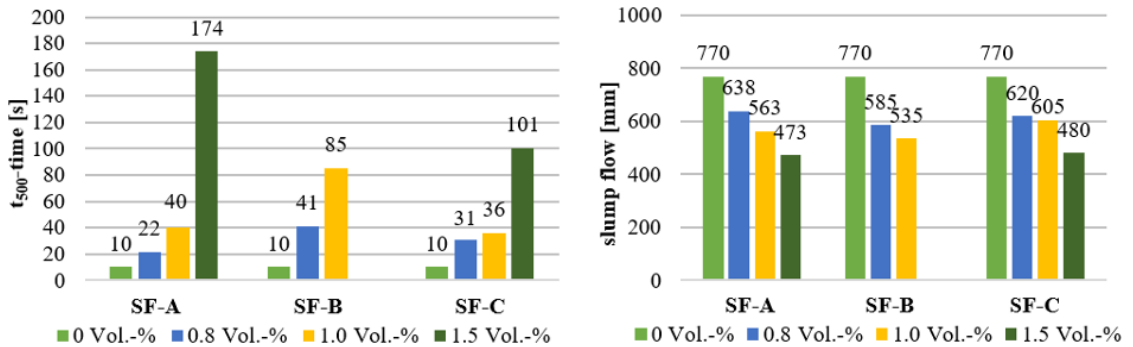
Figure 2. t 500 -time (left) and slump flow (right) depending on the fiber variations and content.